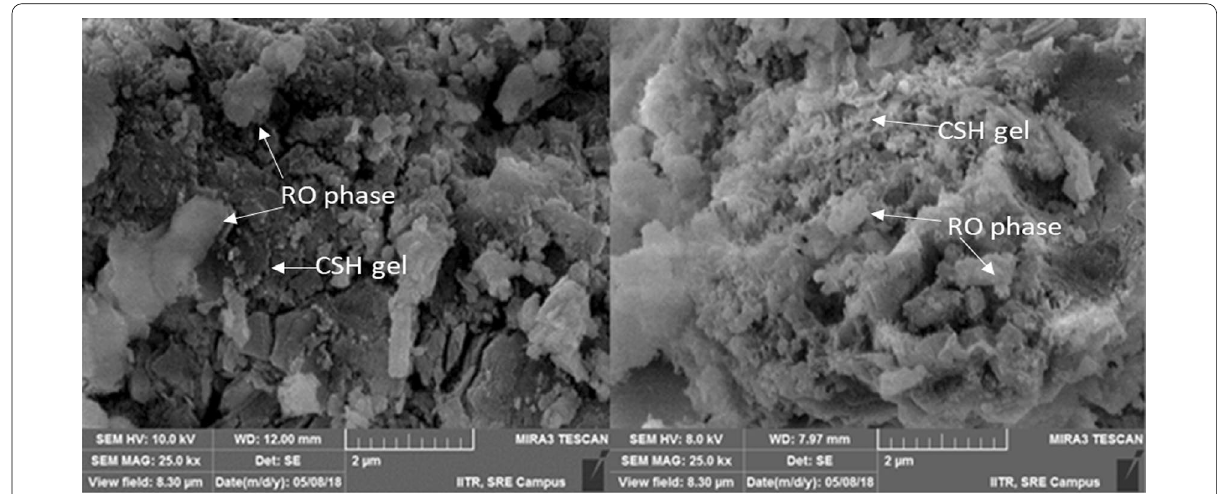
Fig. 9 SEM images of LF slag hydrated paste after 360 days (Wang et al.,